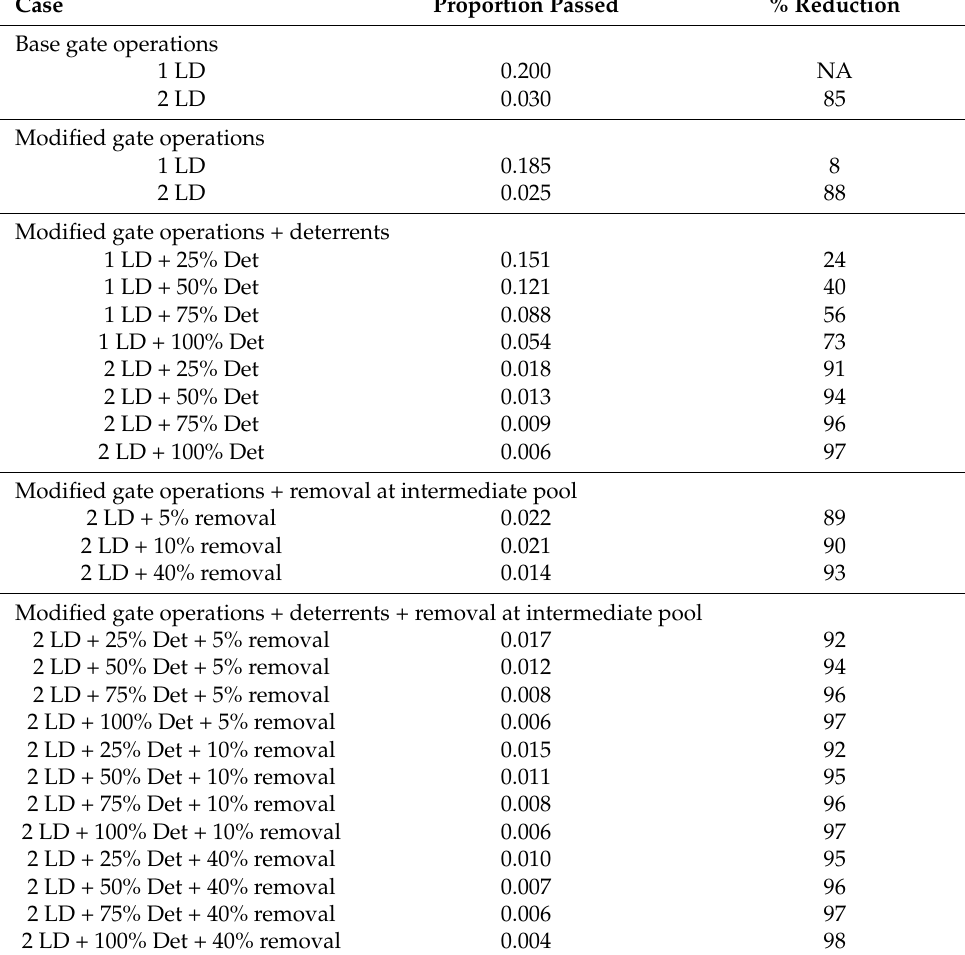
Table 5. Summary of the estimated effects of pairing LDs, modifying their gate operation, adding a deterrent to the lock chamber and removing carp in the intermediate pool between them on the overall annual passage rates of the silver carp population with the size structure presently found in the UMR [48]. The annual proportion of carp passed is averaged across all four flow scenarios. Percent reduction is calculated relative to the proportion passed at a single LD (1 LD) under base gate operations